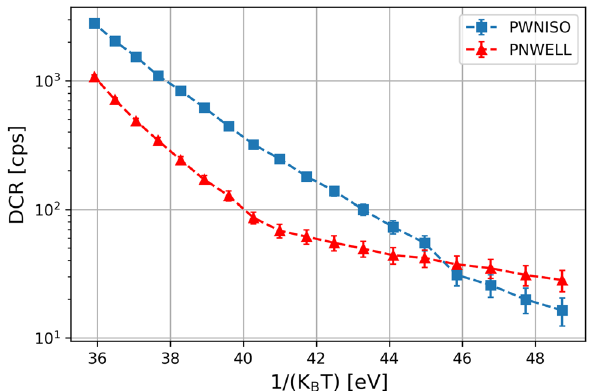
Figure 3. Arrhenius plot for a P+/Nwell SPAD (red triangles) and for a Pwell/Niso SPAD (blue squares).